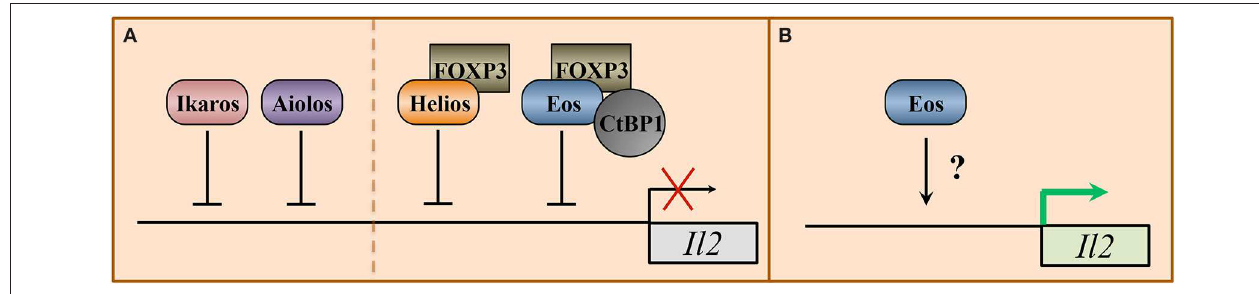
FIGURE 3 | Transcriptional regulation of the interleukin-2 locus by IkZF transcription factors. Signals from the pro-inflammatory cytokine interleukin-2 (IL-2) differentially regulate the expression of T helper cell programs. IL-2 signaling supports the differentiation of T H 1, T H 2, and T REG cell subsets, but represses the differentiation of T H 17 and T FH populations. The Ikaros zinc finger family members Ikaros, Helios, Aiolos, and Eos have all been implicated in regulating IL-2 expression. (A) In anergic CD4 + and T H 17 cells, respectively, Ikaros and Aiolos have been shown to directly associate with the Il2 promoter to repress IL-2 expression. For Ikaros, this association correlates with reduced H3 and H4 acetylation. Aiolos association has been linked to a decrease in both acetylation and the positive histone mark H3K4 me3 at the Il2 promoter and a concurrent increase in H3K9 me3 , which is indicative of a transcriptionally inactive locus. In regulatory T (T REG ) cells, Eos and Helios have both been implicated in IL-2 repression. Mechanistically, Eos forms a protein complex with the T REG lineage-defining transcription factor FOXP3 and C-terminal binding protein (CtBP) to repress Il2 . As with Aiolos, this repression is associated with reduced H3 and H4 acetylation, reduced H3K4 me3 , and increased H3K9 me3 enrichment at the Il2 promoter. Similarly, Helios and FOXP3 are co-enriched at the Il2 locus in T REG cells and correlate with reduced H3 acetylation, consistent with gene repression. (B) In conventional T helper cell populations, in the absence of FOXP3, Eos has been positively linked to